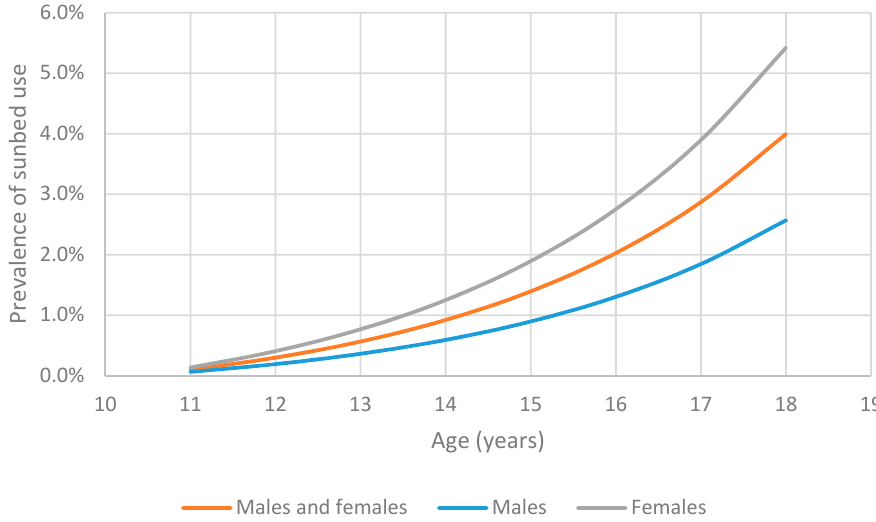
Figure 1. Percentage of 11- to 17-year-olds estimated to use sunbeds in England. Table 1. One-way sensitivity analyses of prevalence of sunbed use in 11- to 17-year-olds. Mean by Age